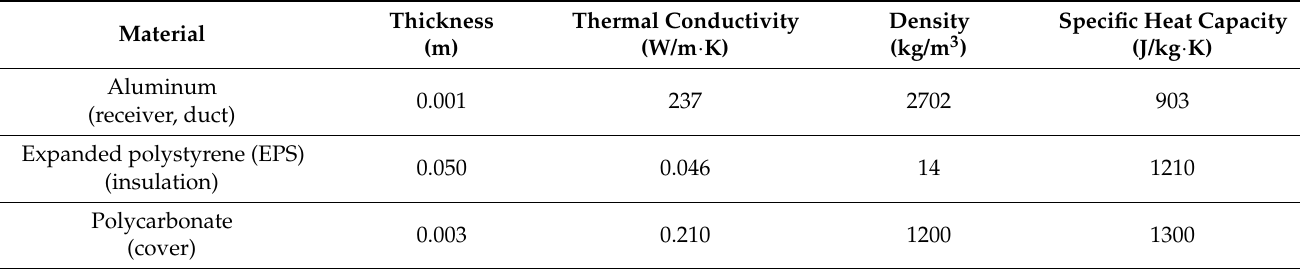
Table 2. Material properties of the U-shape double-pass CPC elements.